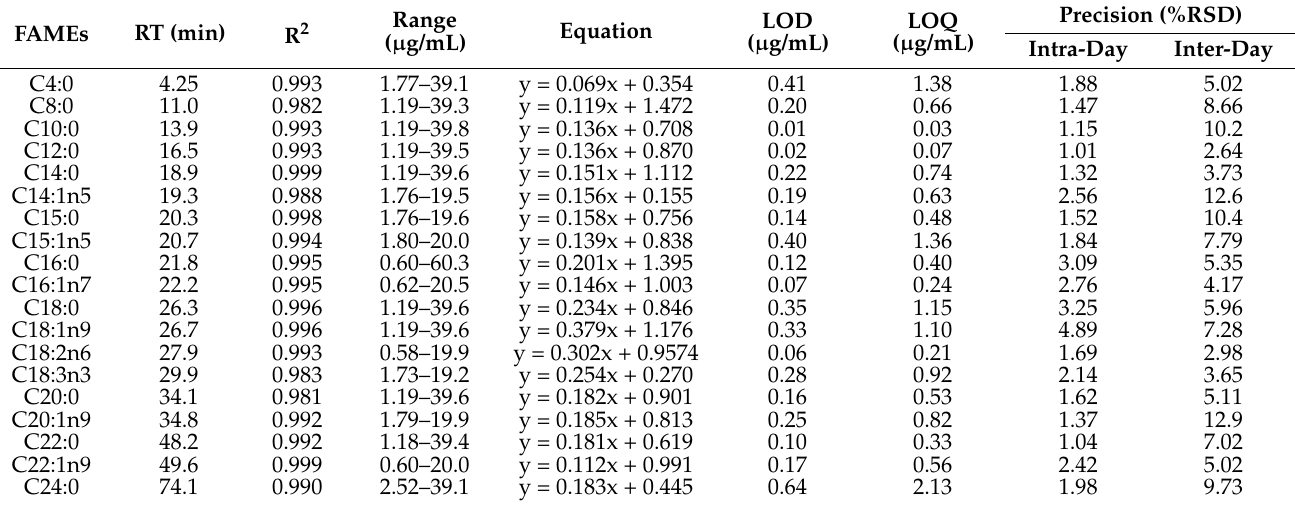
Table 1. Parameters of method